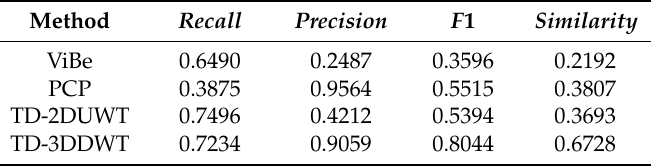
Table 6. Comparison of average metrics for TP96.